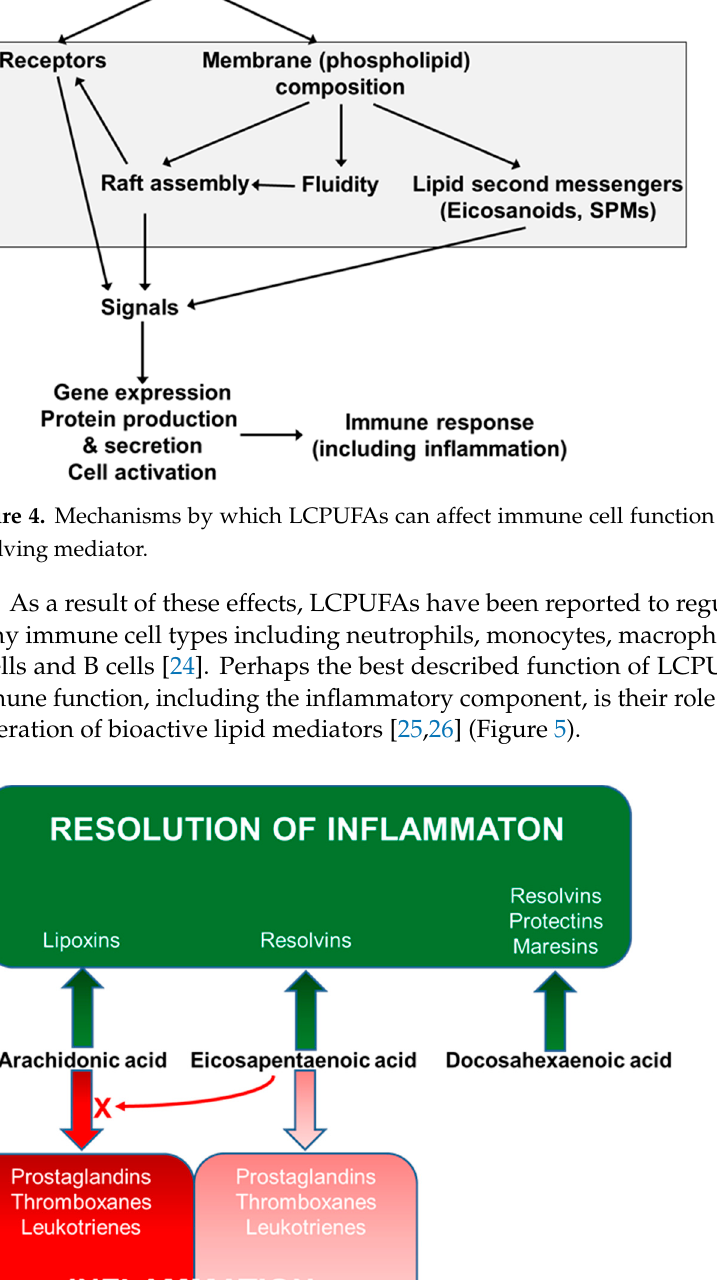
6 of 21 Figure 3. Pathway of long-chain polyunsaturated fatty acid (LCPUFA) biosynthesis from essential fatty acid precursors. Immune cell membranes contain AA, EPA and DHA. AA is the most abundant of these LCPUFAs, while DHA is usually the most abundant n-3 LCPUFA. In adults, AA typically comprises 15 to 20% of total fatty acids in blood mononuclear cells (a mixture of